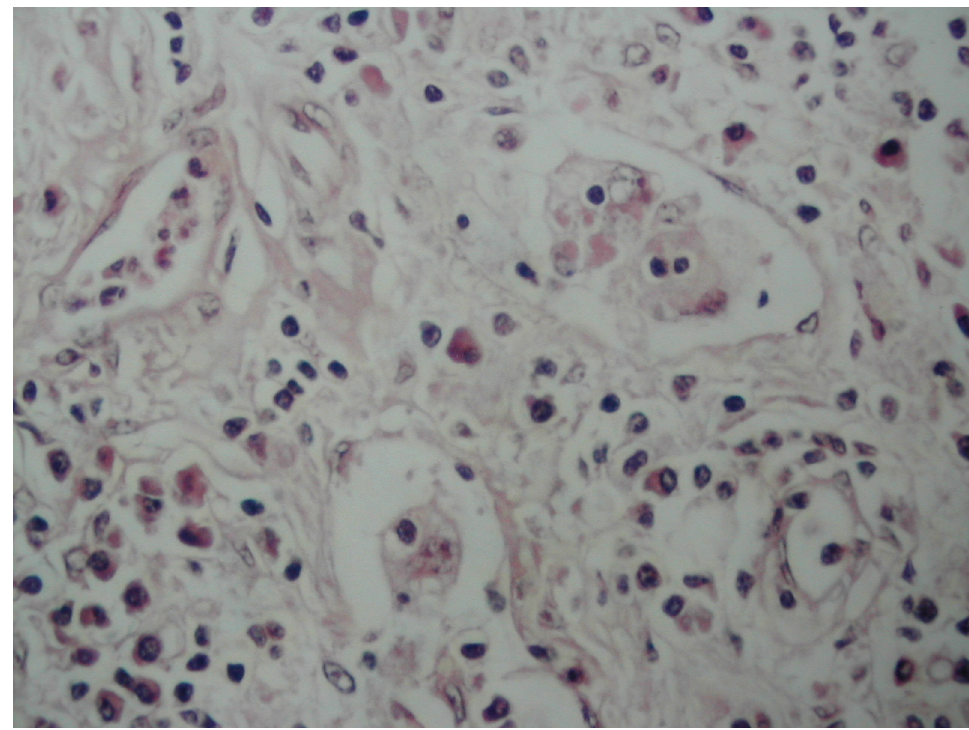
FIGURE 2. Pleural biopsy specimen: infiltrate with lymphoid cell clusters alternating with pale areas representing the histiocytic cell population (hematoxylin-eosin stain; magnitude ×